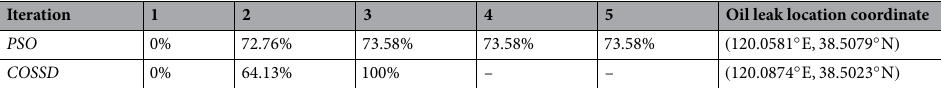
Table 1. The optimization result of the PSO method and the proposed COSSD